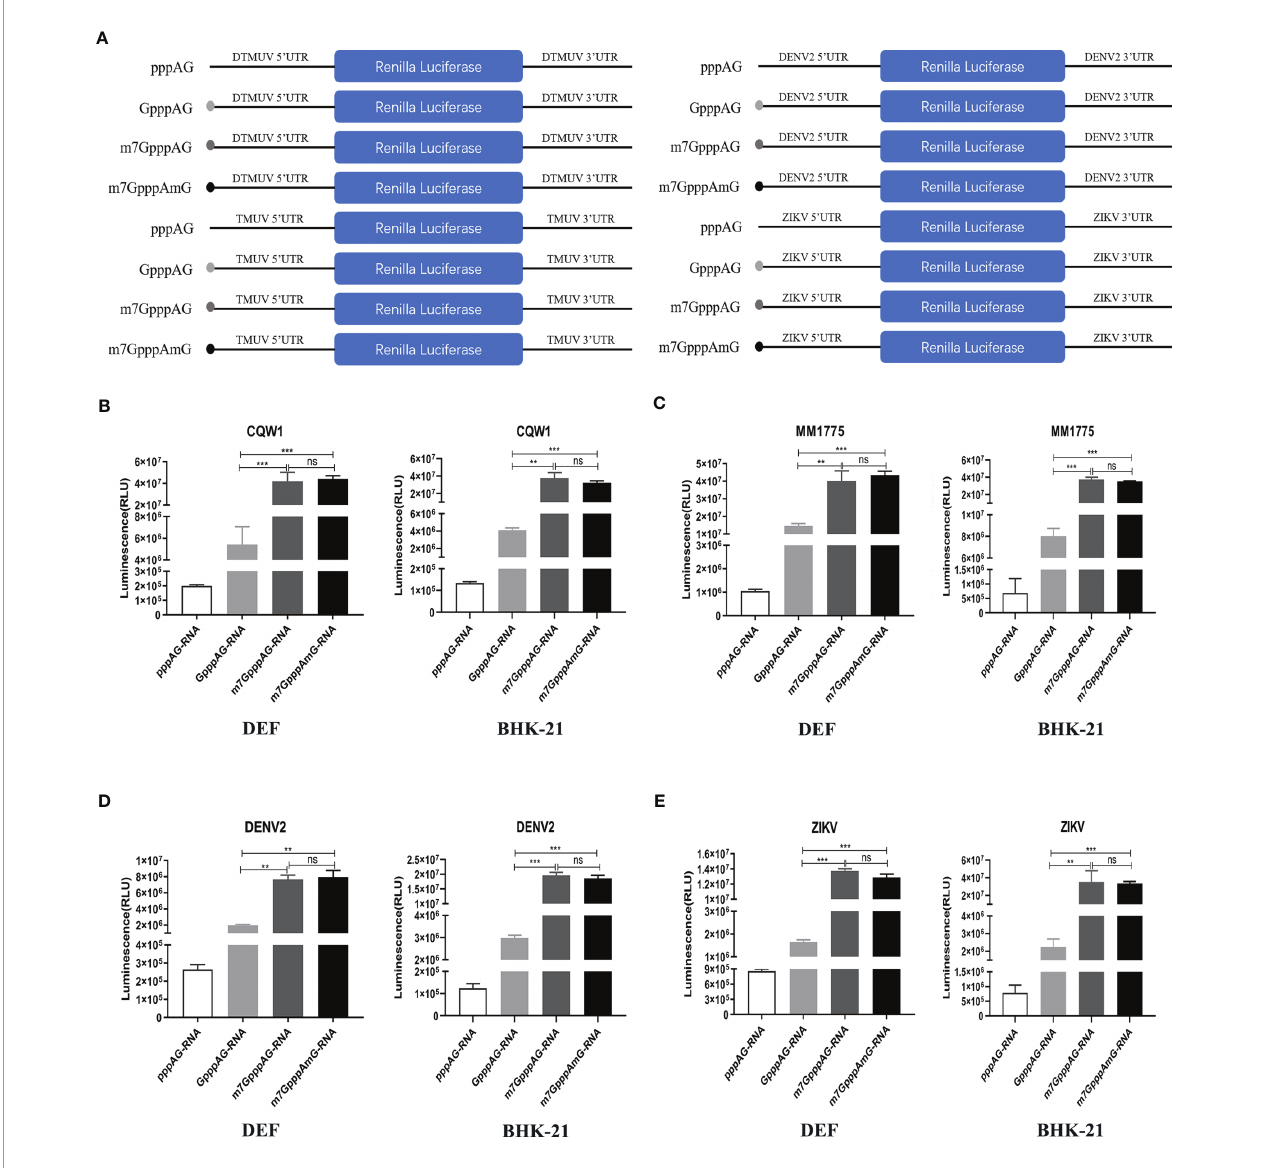
FIGURE 6 | Defect in N-7 methylation leads to translational suppression of mutant viruses. (A) The construction schematic of the RNA translation templates with the different components of cap structures for TMUV, DENV2, and ZIKV. (B – E) DEF and BHK-21 Cells were transfected with equal amounts of RNAs. The RLuc activities of different RNAs of TMUV strain CQW1 (B) , TMUV strain MM1775 (C) , DENV2 (D) and ZIKV (E) were measured at 4 h post-transfection. Each of these was conducted with three parallel replicates. Bars show means ± SDs. *** P < 0.001; ** P < 0.01 (one-way ANOVA). ns, no signi fi